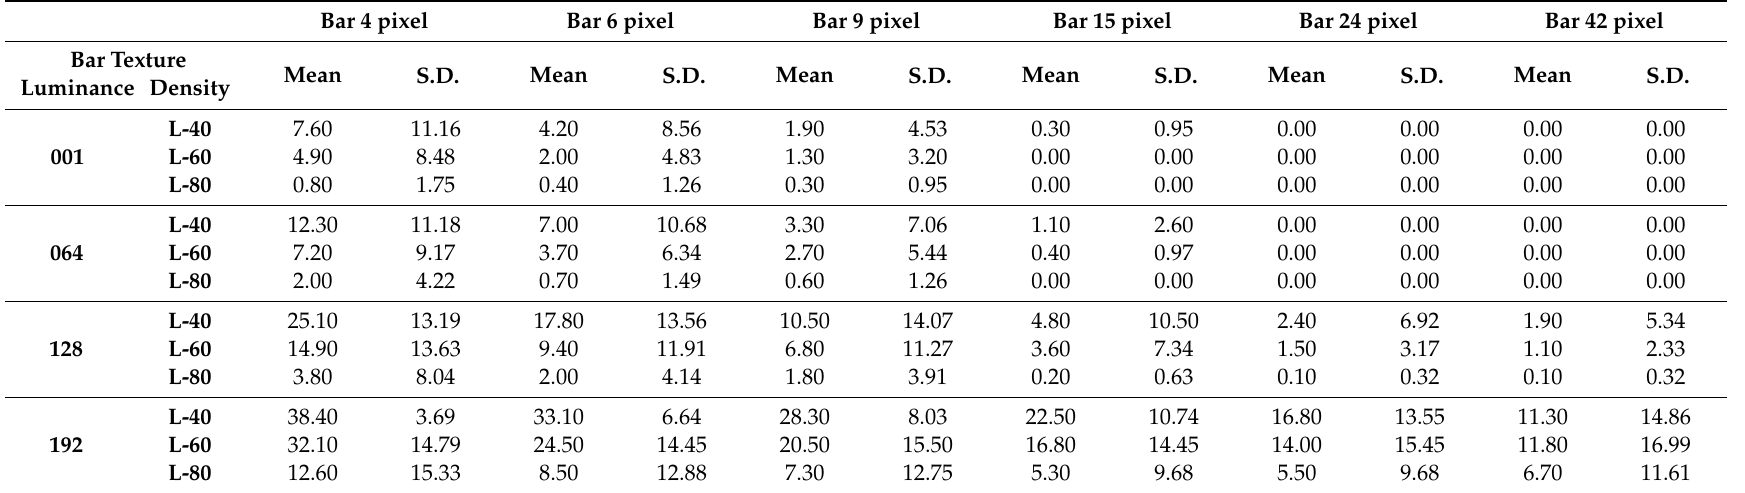
Table 6. Results of the second group of tests: textured Bar on uniform Background, Bar “Large” Texture manipulation (Luminance and